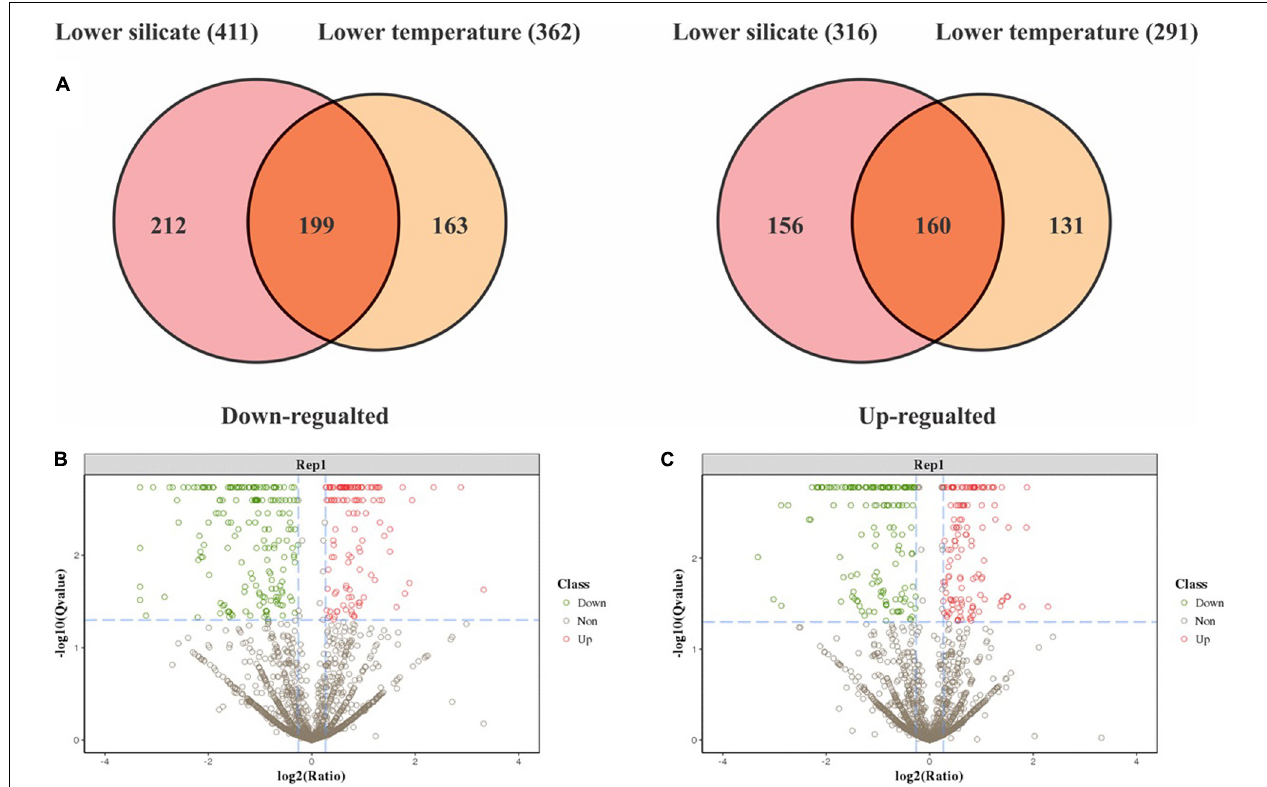
FIGURE 3 | The Venn diagram depicts common and specific differentially expressed proteomic responses between silicate and temperature limitation (A) , and volcano plots of differentially expressed proteins in lower-silicate cells (B) , and lower-temperature cells (C)